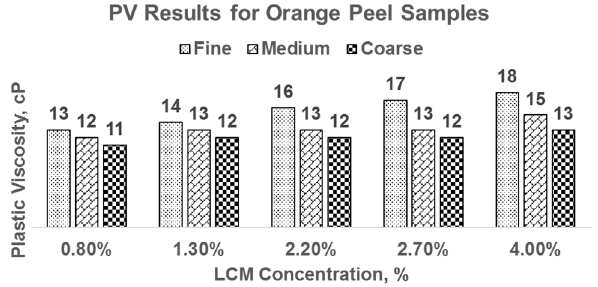
Fig. 3 Yield point results for orange peel samples